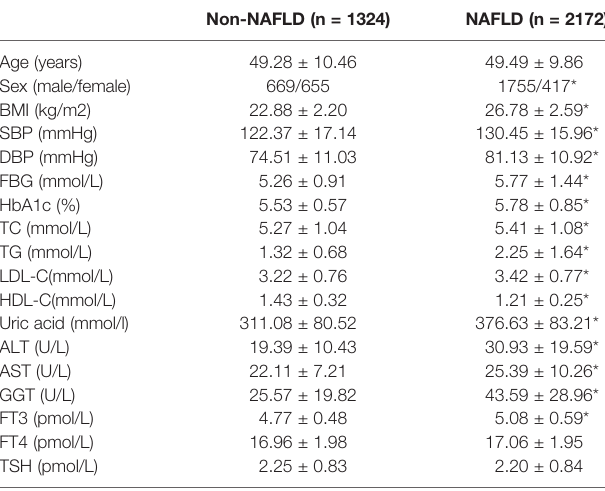
TABLE 1 | Baseline characteristics of individuals with or without NAFLD.